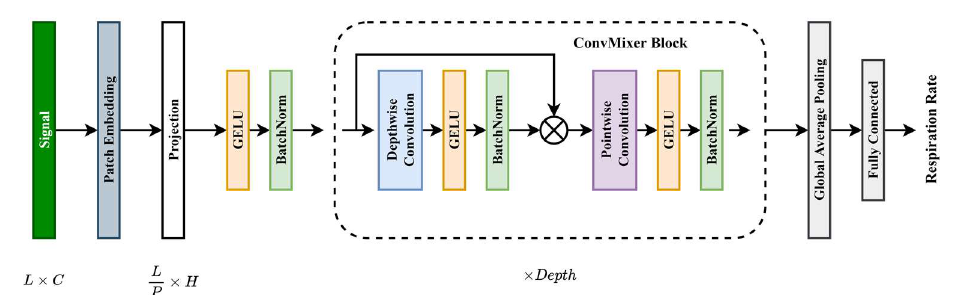
Figure 2. ConvMixer architecture.